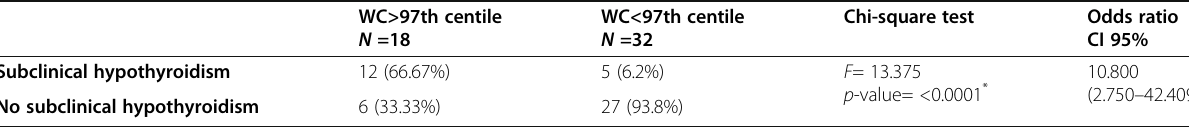
Table 4 The association between central obesity and subclinical